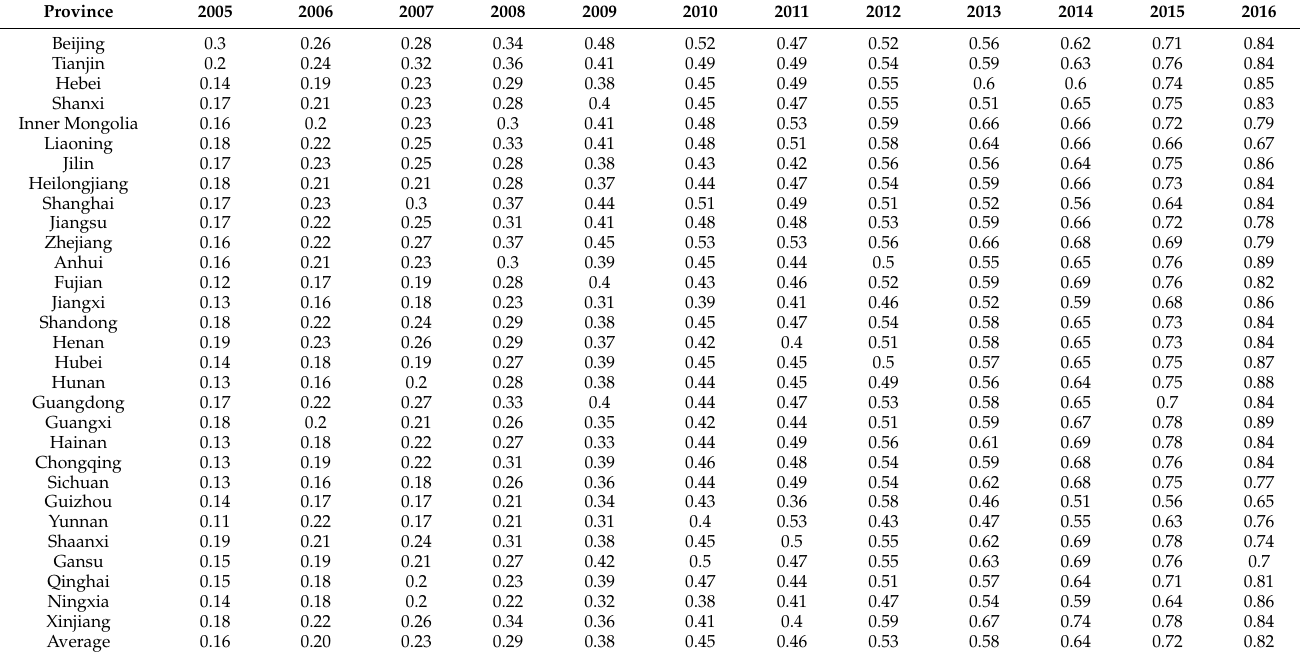
Table 5. The comprehensive development levels of green